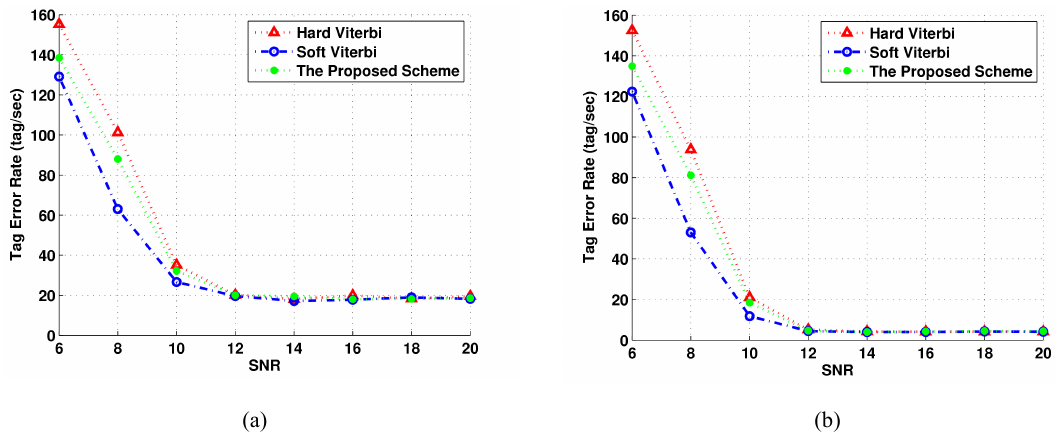
Figure 6. Tag Error Rate versus SNR (dB) with four different values of the ratio T on / T s : ( a ) T on / T s = 5 and ( b ) T on / T s = 20.